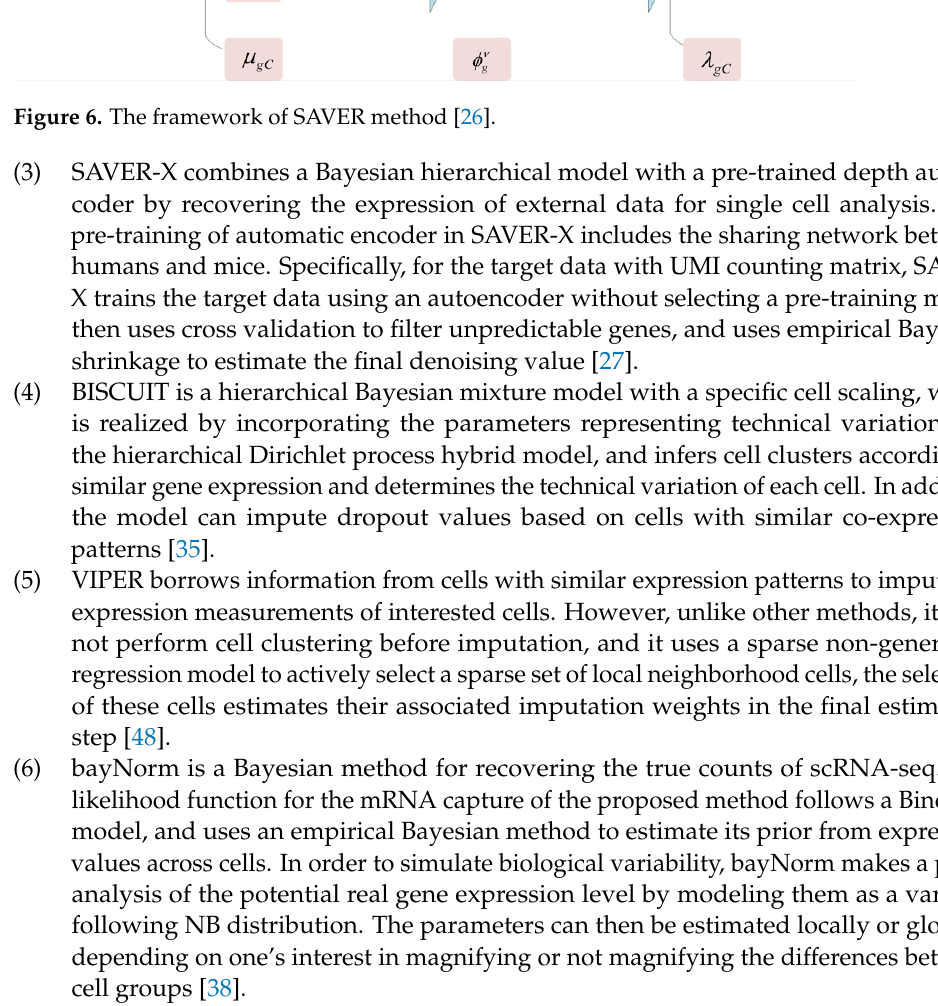
Table 2. The availability links, programming language, whether a package is available, year of presentation, operative system, distribution compatibility and reference of the representative meth ‐ ods based on model.